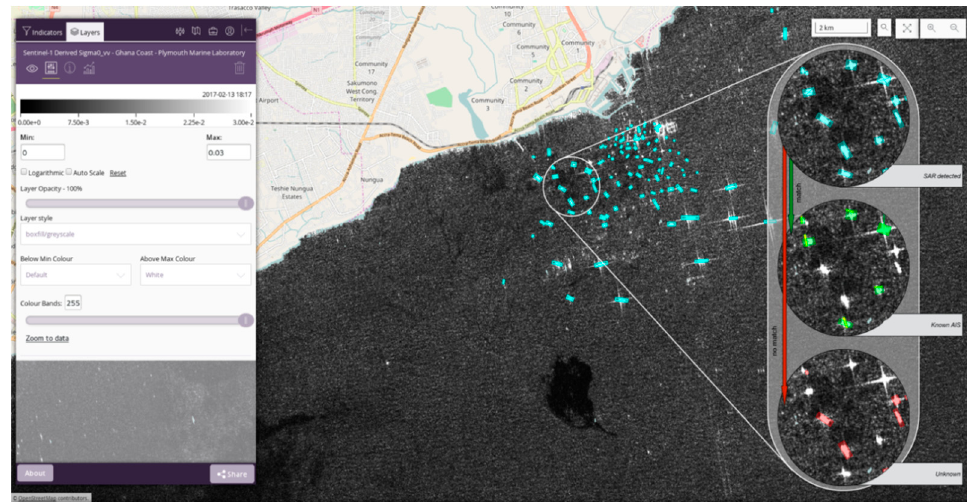
Figure 13. The web portal interface. Note that the circular “lenses” on the right-hand side are provided to highlight the various decision layers available, and are not a live web-portal feature.